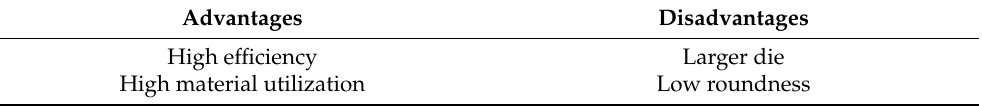
Table 1. Comparison between MSCWR process and forging process